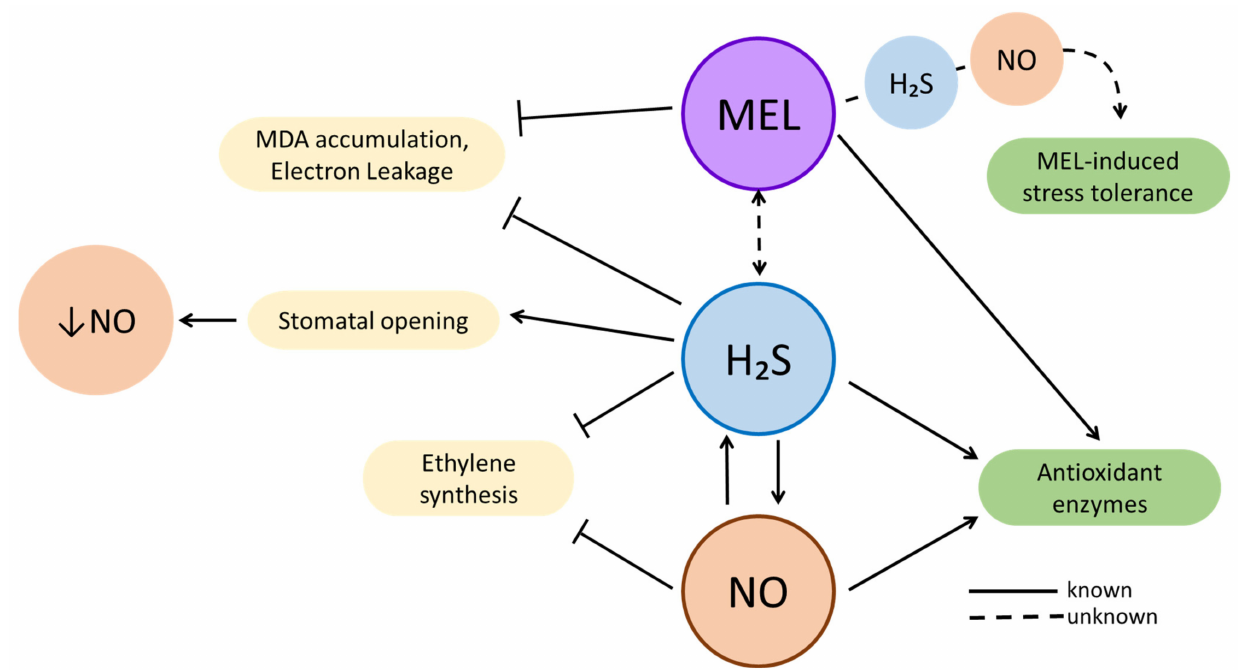
Figure 3. H 2 S interactions with MEL or NO during abiotic stress